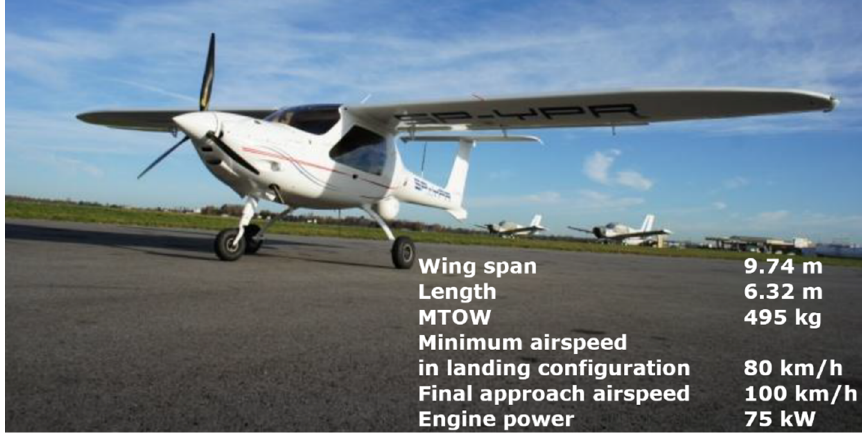
Figure 2. The MP−02A experimental airplane, as used in the research. Figure 2. The MP − 02A experimental airplane, as used in the